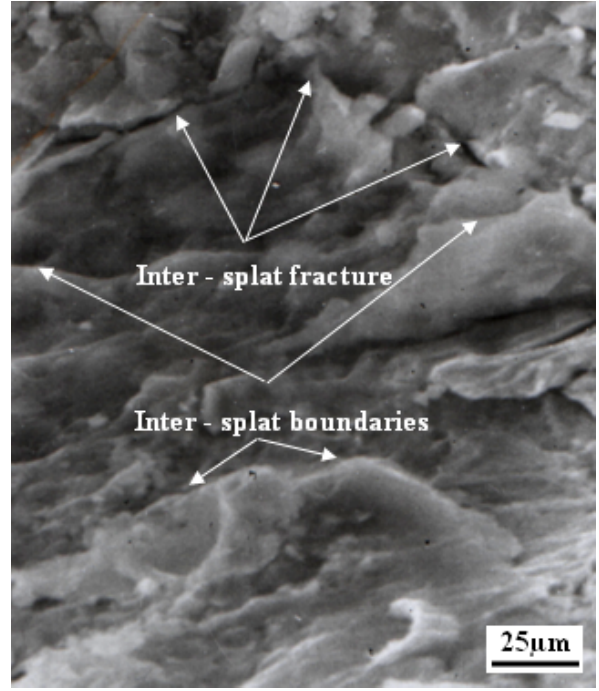
Figure 8: (SEM) fracture morphologies of Al-12Si coatings